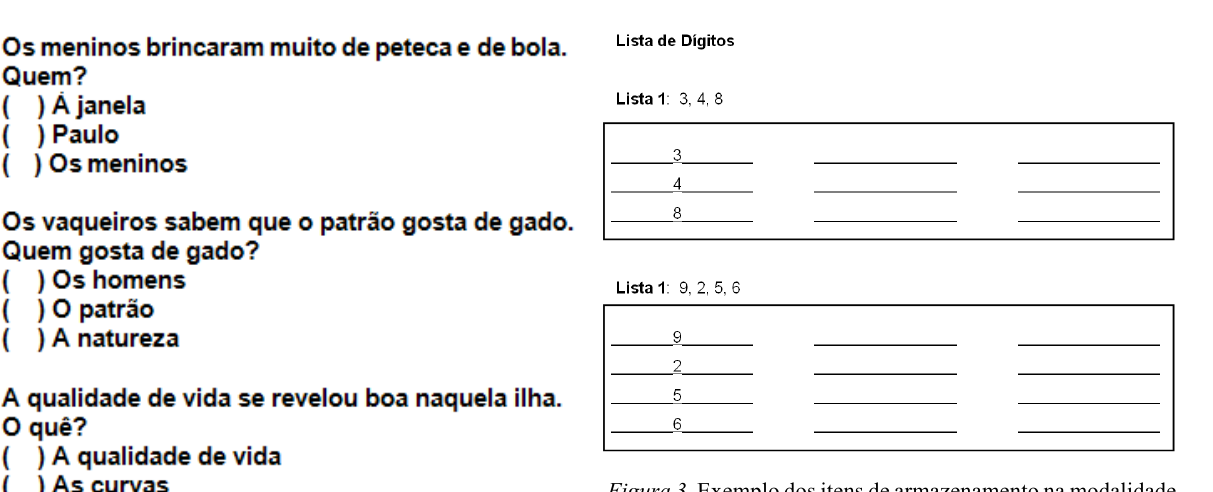
Figura 3 . Exemplo dos itens de armazenamento na modalidade numérica da BAMT-UFMG